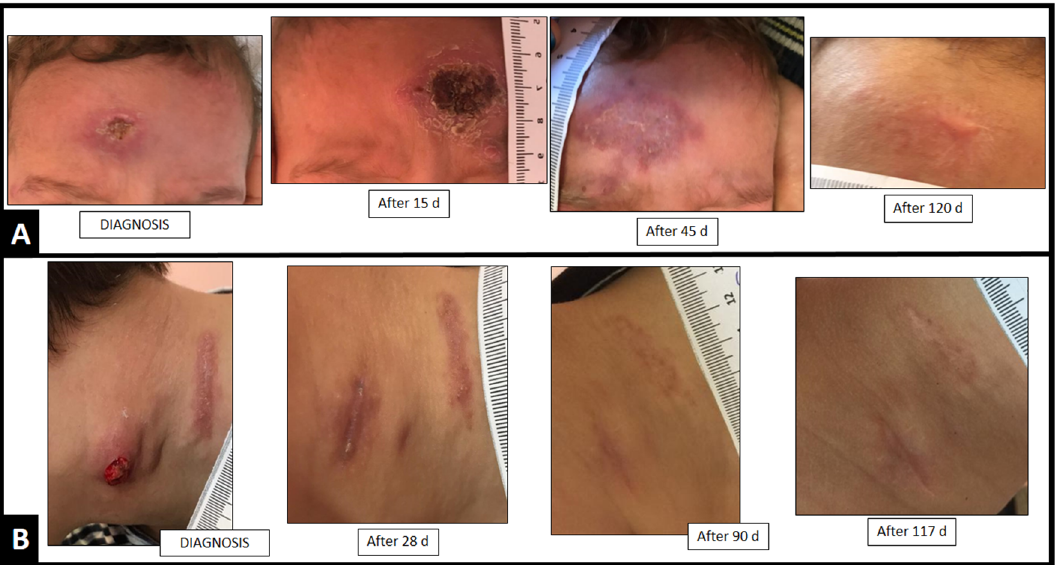
Figure 3. Clinical cure in days (d) of pediatric patients with cutaneous sporotrichosis from southern Brazil treated with ITZ and/or KI. Lymphocutaneous cases of sporotrichosis localized to face ( A ) and in neck ( B ).